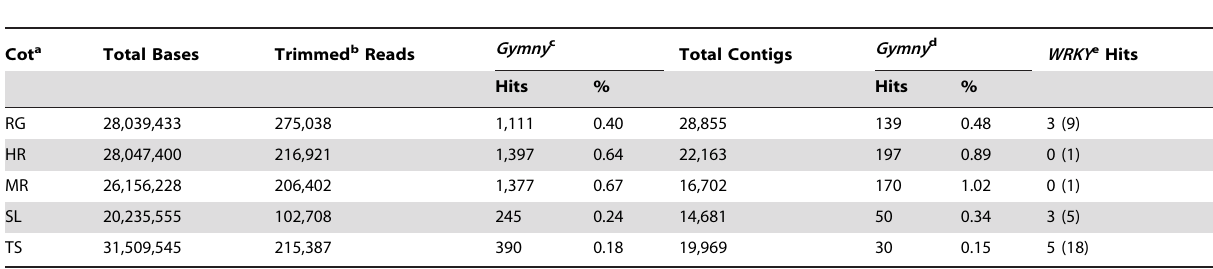
Table 3. Gymny and WRKY distribution in Pinus taeda genomic fractions.